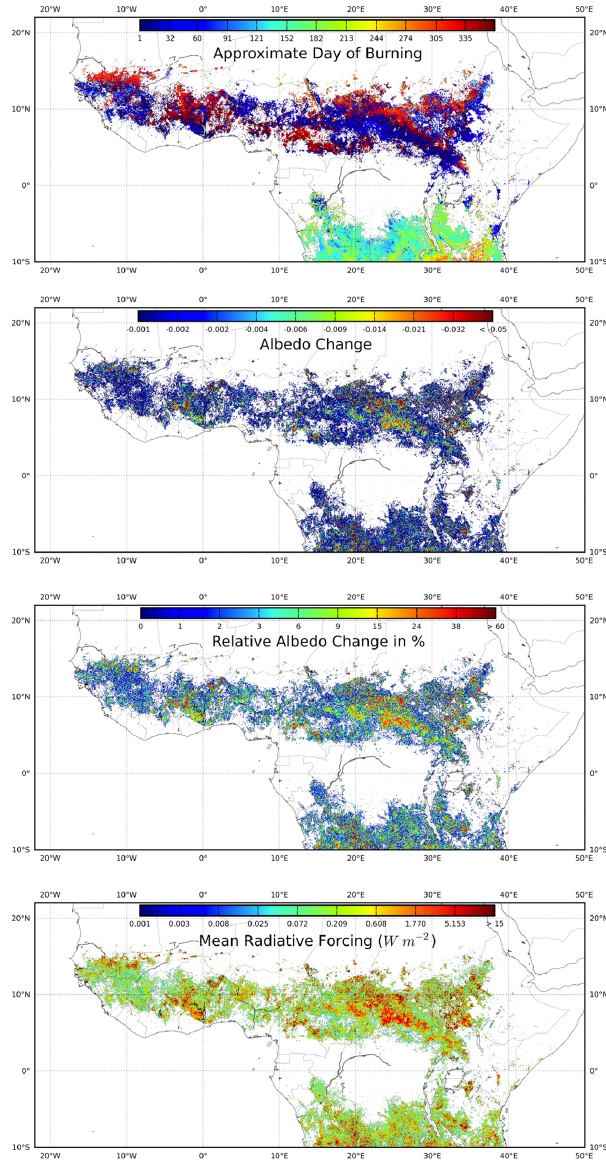
Figure 5. The approximate day of burning; the “instantaneous” shortwave albedo change in areas affected by fire; the relative change in albedo in %; and the associated radiative forcing in Wm − 2 is shown for the Sahel during